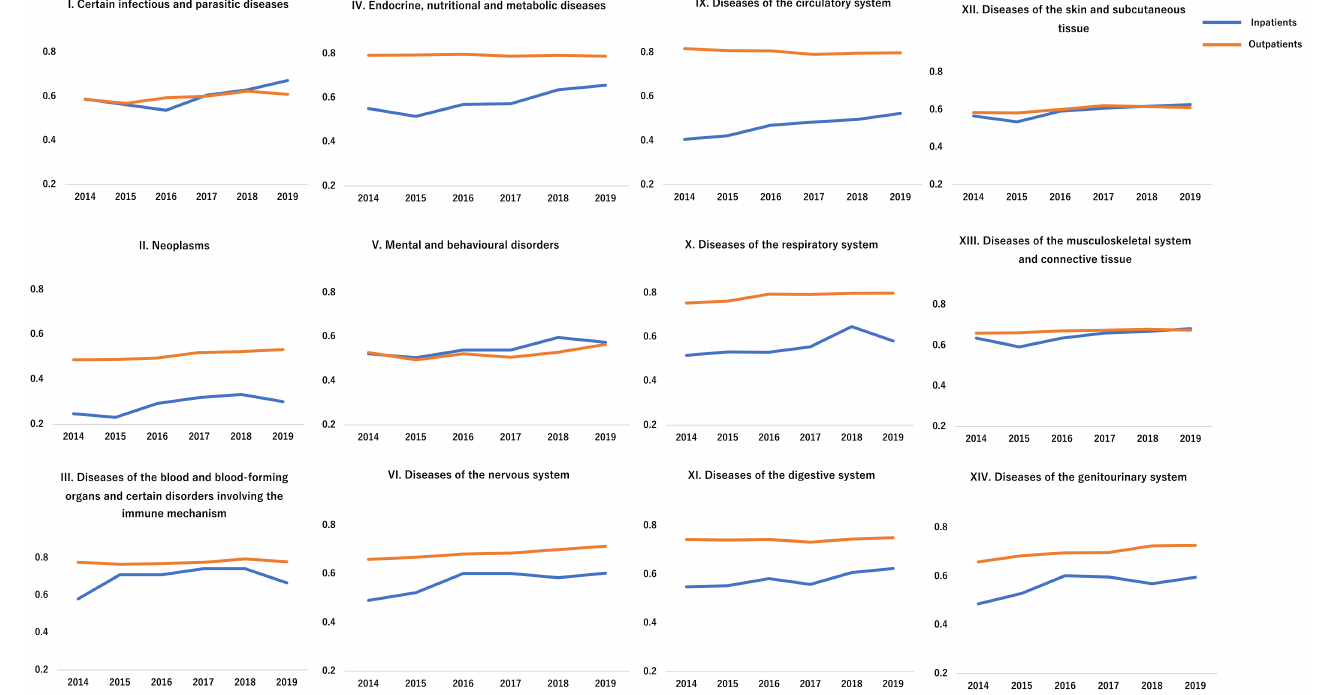
Figure 3. Changes in the rate of comprehensiveness during the study